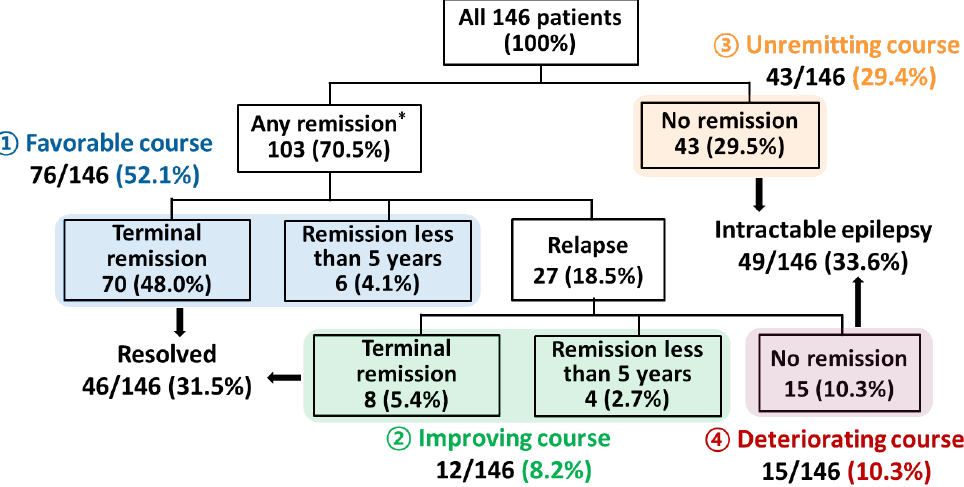
Figure 2. Long-term outcomes of the patients with infantile-onset epilepsy. * First remission (seizure free > 2 years) from the diagnosis.